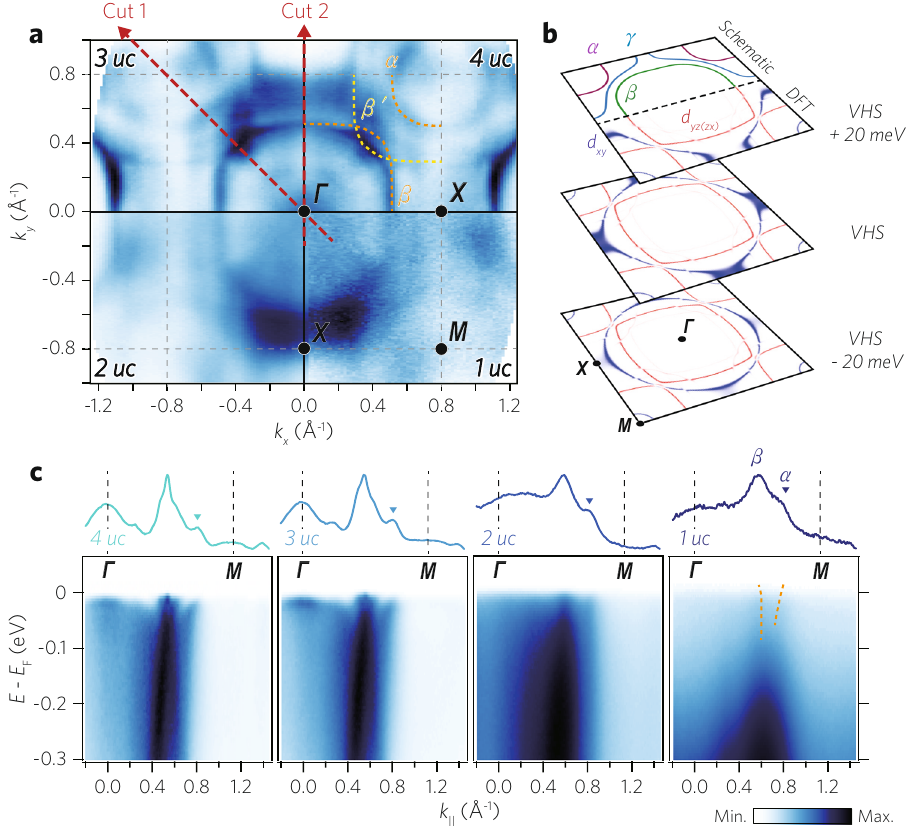
Fig. 2 Fermi surfaces (FSs) of ultrathin SRO fi lms. a FSs of ultrathin SRO layers with a speci fi ed thickness. Angle-resolved photoemission spectroscopy (ARPES) data were taken at 10 K with He-I α light (21.2 eV) and integrated within E F ± 10 meV. b Energy isosurfaces of two-dimensional (2D) SRO calculated by density functional theory (DFT) calculation, together with schematic energy isosurfaces. DFT results are color-coded for d xy (blue) and d yz , zx (red) orbital contributions to the bands. The VHS represents Van Hove singularity. c Γ - M high-symmetry cuts (Cut 1 in ( a )) and momentum distribution curves (MDCs) at E F . The inverted triangles next to MDCs represent peaks of the α band. Both α and β bands are resolved in 1